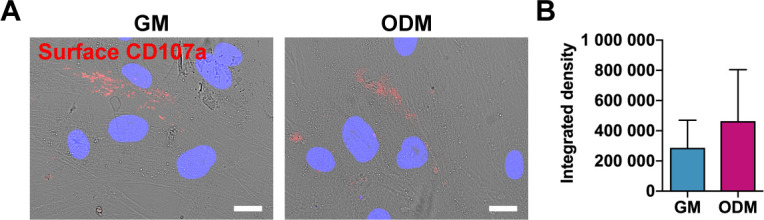
No change in membranous CD107a during osteogenic differentiation among human ASCs.(A) Immunocytochemical staining for membranous CD107a expression in the absence or presence of osteogenic differentiation medium for 3 d of differentiation. CD107a immunoreactivity appears red, DIC appears white. White scale bar: 20 μm. (B) Photometric quantification of membranous CD107a immunofluorescence with or without osteogenic differentiation. GM: Growth medium; ODM: Osteogenic differentiation medium. Data repeated in experimental triplicate. Statistical analysis was performed using a two-tailed Student t- test.